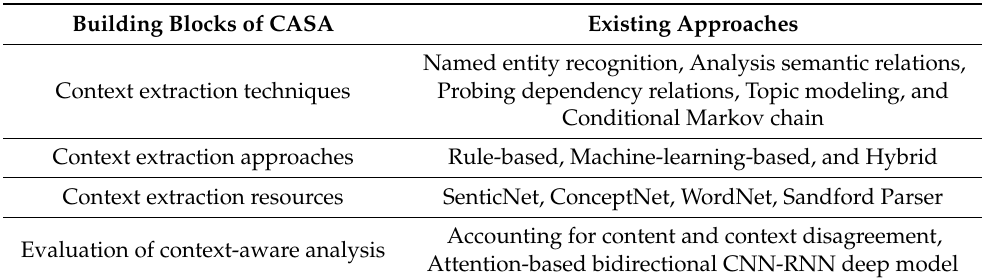
Table 3. Fundamentals of Context-aware Sentiment Analysis